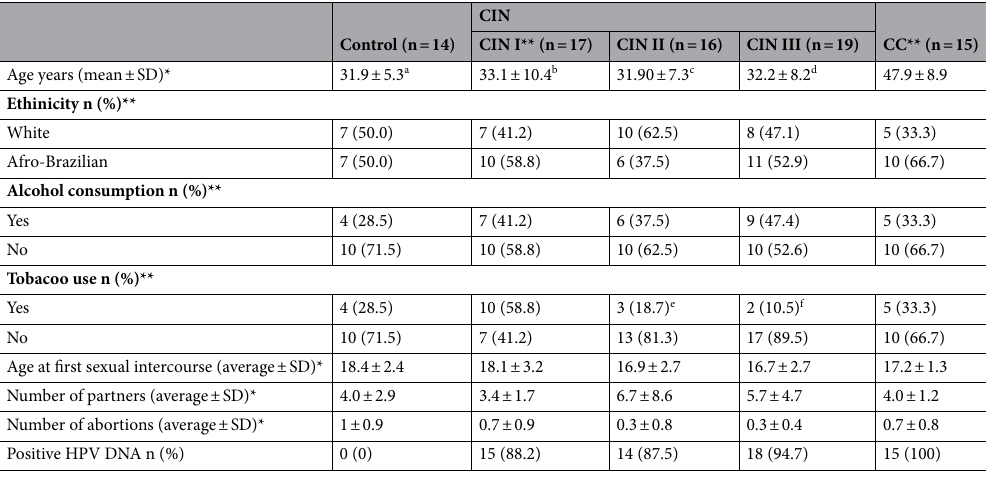
Table 1. Clinical and environmental data in cervical HPV-associated lesion and cancer. *One way Anova test and Dunn’s multiple comparison post test; ** χ 2 test. ** CIN cervical intraepithelia neoplasia, CC cervical cancer. a p < 0.01 control versus CC, b p < 0.01 CIN I versus CC; c p < 0.01 CIN II versus CC; d p < 0.001, CIN III versus CC; e p < 0.01 CIN II versus CIN I; f p < 0.001 CIN III versus CIN